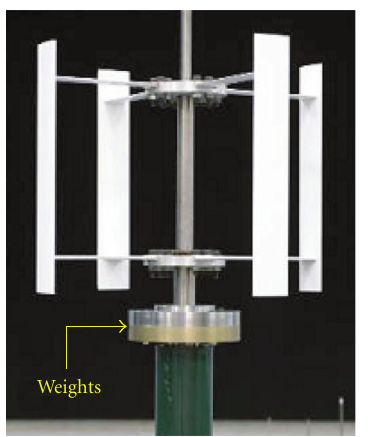
Figure 2: Experimental VAWT rotor with weights added to rota- tional axis to increase the moment of inertia.